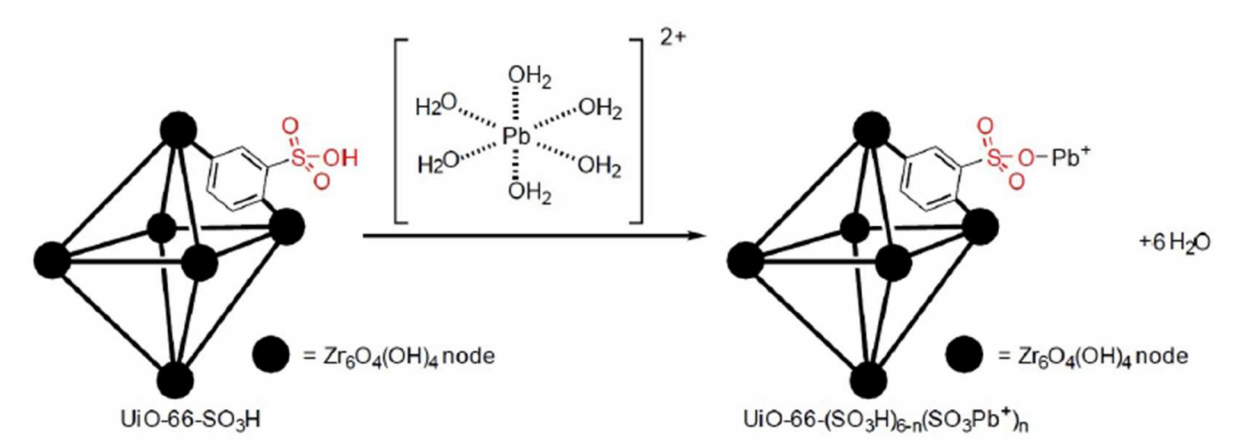
Figure 9. Diagram of adsorption of [Pb(OH 2 ) 6 ] 2+ on SO 3 H-UiO-66(Zr) in water. Adapted from [74]. Based on the modifiable host-guest interactions among LMOFs and analytes, many MOFs with nitrogen centers, amine groups, and alkyne groups have been engineered to detect Hg 2+ [78]. For example, ref. [79] fabricated a butyne-modified luminescent MOF probe with high chemical and hydrolytic stability in water, namely UiO-66@butyne, to detect Hg 2+ through the oxymercuration process. UiO-66@butyne was obtained by the reaction of a Zr ion and 2,5-bis (but-3-yn-1-yloxy) terephthalic acid, in which the butyne moiety acted as the recognition site for Hg 2+ . The MOF also showed high selectivity for Hg 2+ with a significant LOD of 10.9 nmol L − 1 and a rapid response time of 3 min. Zhang et al. obtained a series of amino-functionalized LMOFs with high oxidation state central metals (Al 3+ , Zr 4+ , Cr 3+ , Fe 3+ , and Ti 4+ ), enabling trace detection of Hg 2+ through strong co- ordination of amino groups with Hg 2+ [80]. Additionally, the intrinsic fluorescence intensity of MOFs is dominated by the effect of LMCT. Particularly, NH 2 -MIL-53(Al) demonstrated an outstanding ability for Hg 2+ detection with a wide response range (1–17.3 µ M), quite low detection limit (0.15 µ M), excellent selectivity, broader pH adaptation (4.0–10.0), and strong anti-interference capacity. Khatun et al. produced a thiazolothiazole-based LMOF with Hg 2+ -sensing capabilities, namely Zn 2 (NDC) 2 (DPTTZ), in which naphthalene dicar- boxylate (NDC) struts served as antenna chromophores and energy donors and N , N (cid:48) -di(4- pyridyl)thiazolo-[5,4- d ]thiazole (DPTTZ) pillars as complementary energy acceptors and light emitters [81]. In the presence of Hg 2+ , the photoluminescence of Zn 2 (NDC) 2 (DPTTZ) MOF underwent a significant red-shift to 450 nm followed by quenching. The